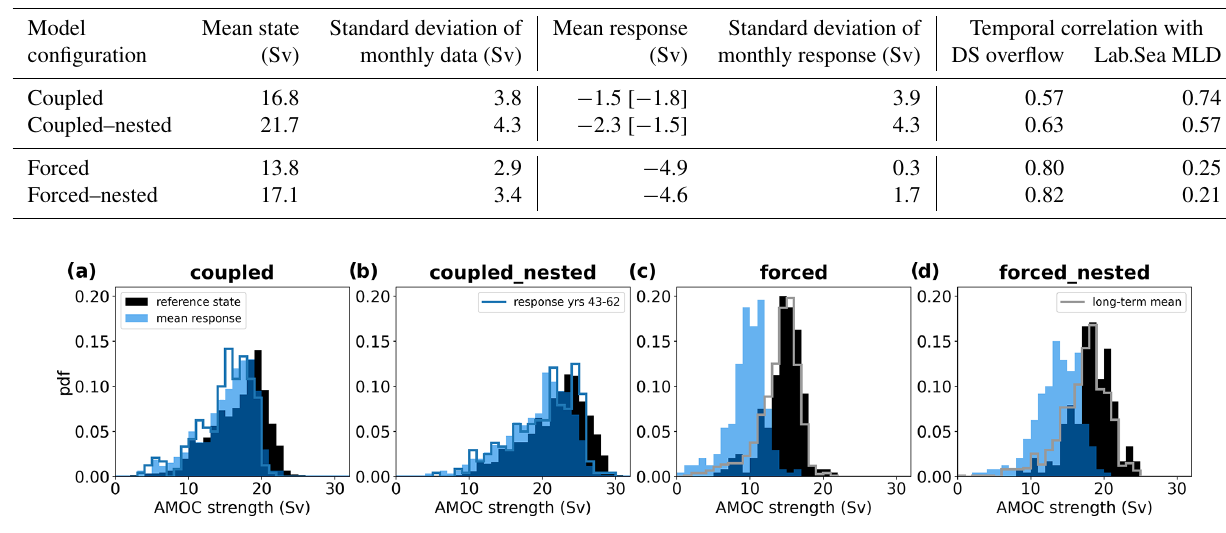
Figure 4. Statistical distribution of monthly mean AMOC maximum strength (Sv) in model reference states (black bars) and perturbed states (blue bars, transparent). Blue outlines in panels (a) and (b) show response distribution for years 43–62, and light gray lines in pan- els (c) and (d) depict the distribution of the long-term mean period (years